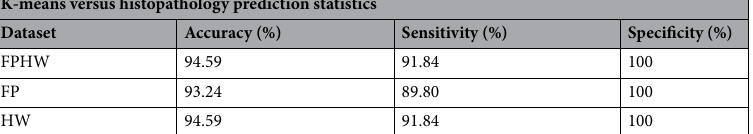
) the full set of 9 ●